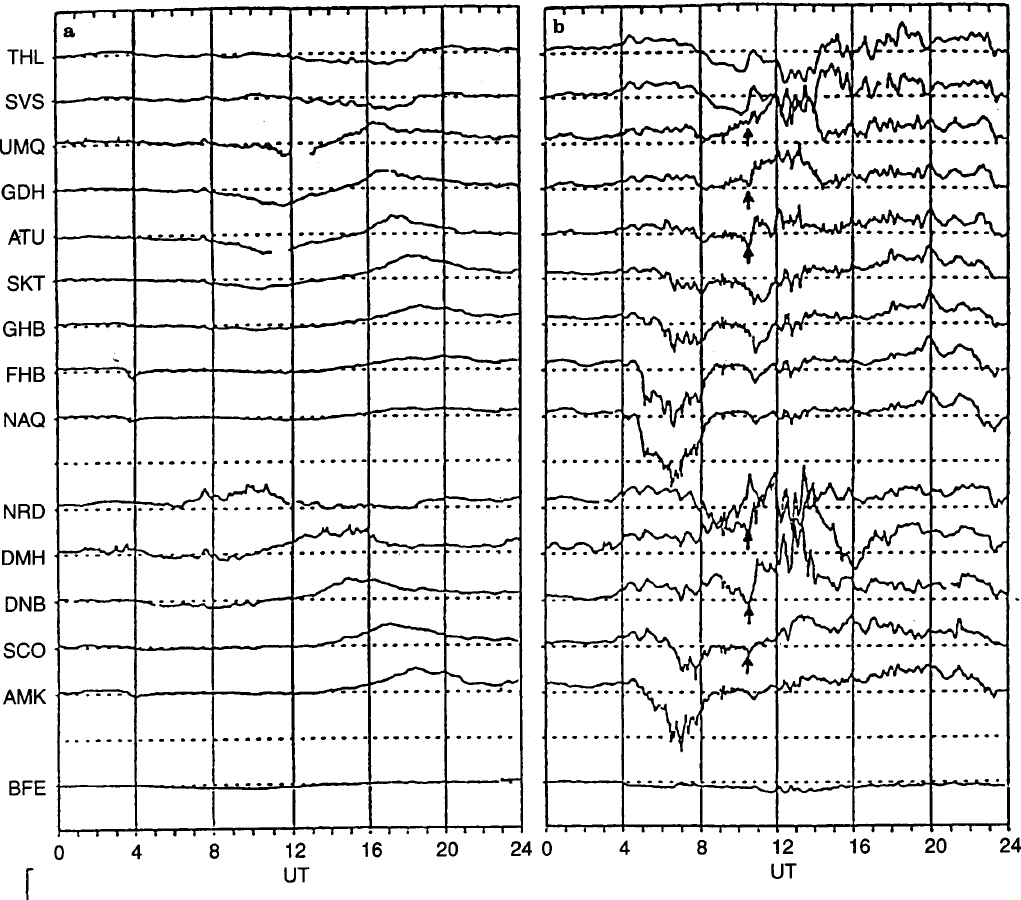
Fig. 5. a H -component on 26 May and b 27 May 1993 recorded on the Greenland chain. The arrows indicate the beginning of the eastward electrojet subsequent to the westward electrojet which occured at about 0400 UT